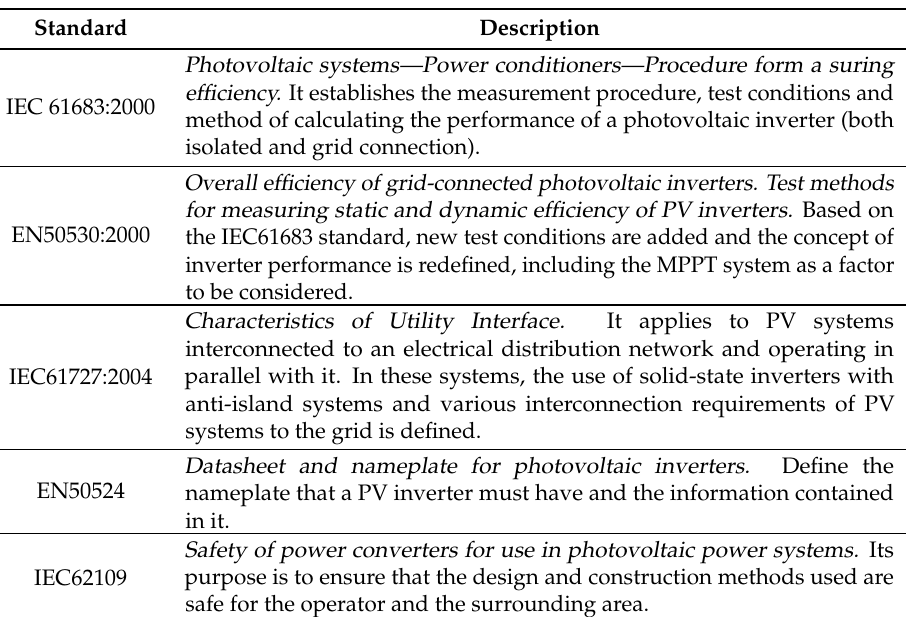
Table 2. Standards applicable to PV inverters.